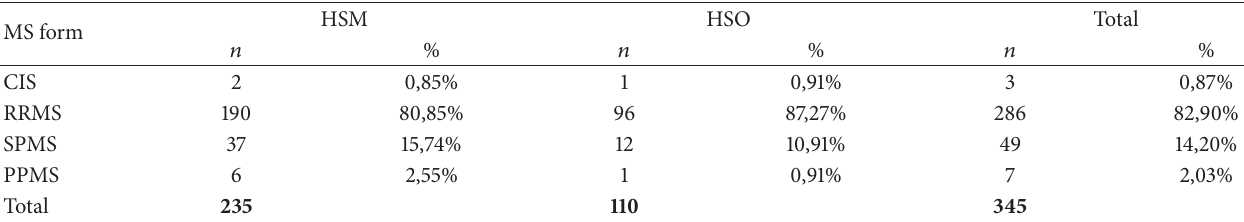
Table 2: Most of patients have the Relapsing-Remitting form of Multiple